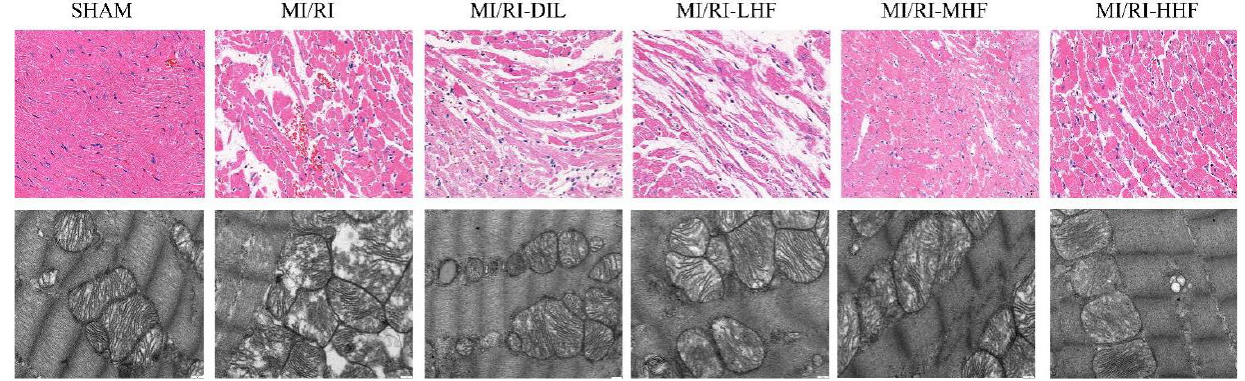
Figure 3. Effect of HF on the histopathological (400×, scale = 50 μm, n = 3) and ultrastructural changes (20,000×, scale = 1 μm, n = 3) of the LV from each group.